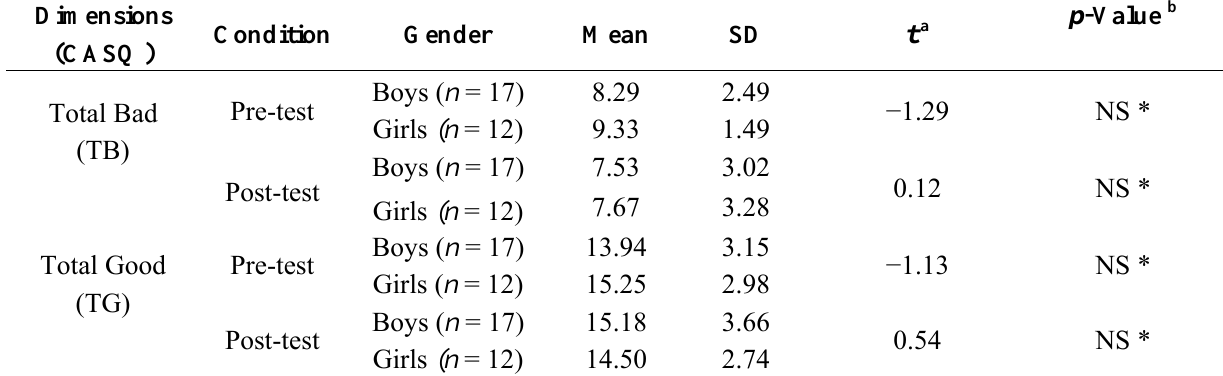
Table 3. Differences across gender in the intervention group on dimensions of the CASQ.